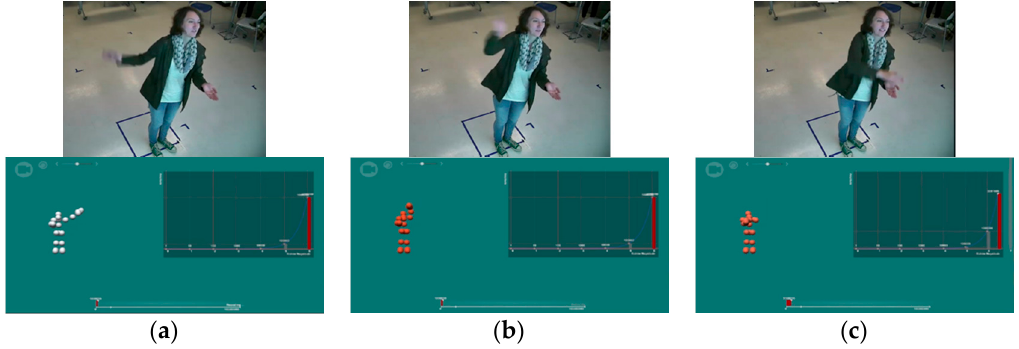
Figure 2. The student (above) and skeleton (below) showed the steps of making a multiplication gesture: ( a ) holding her left hand palm up in front of her stomach and extending her right arm; ( b ) making an overhead sweeping motion with the right arm; ( c ) folding the right arm such that her right hand meets her left hand in front of her body.